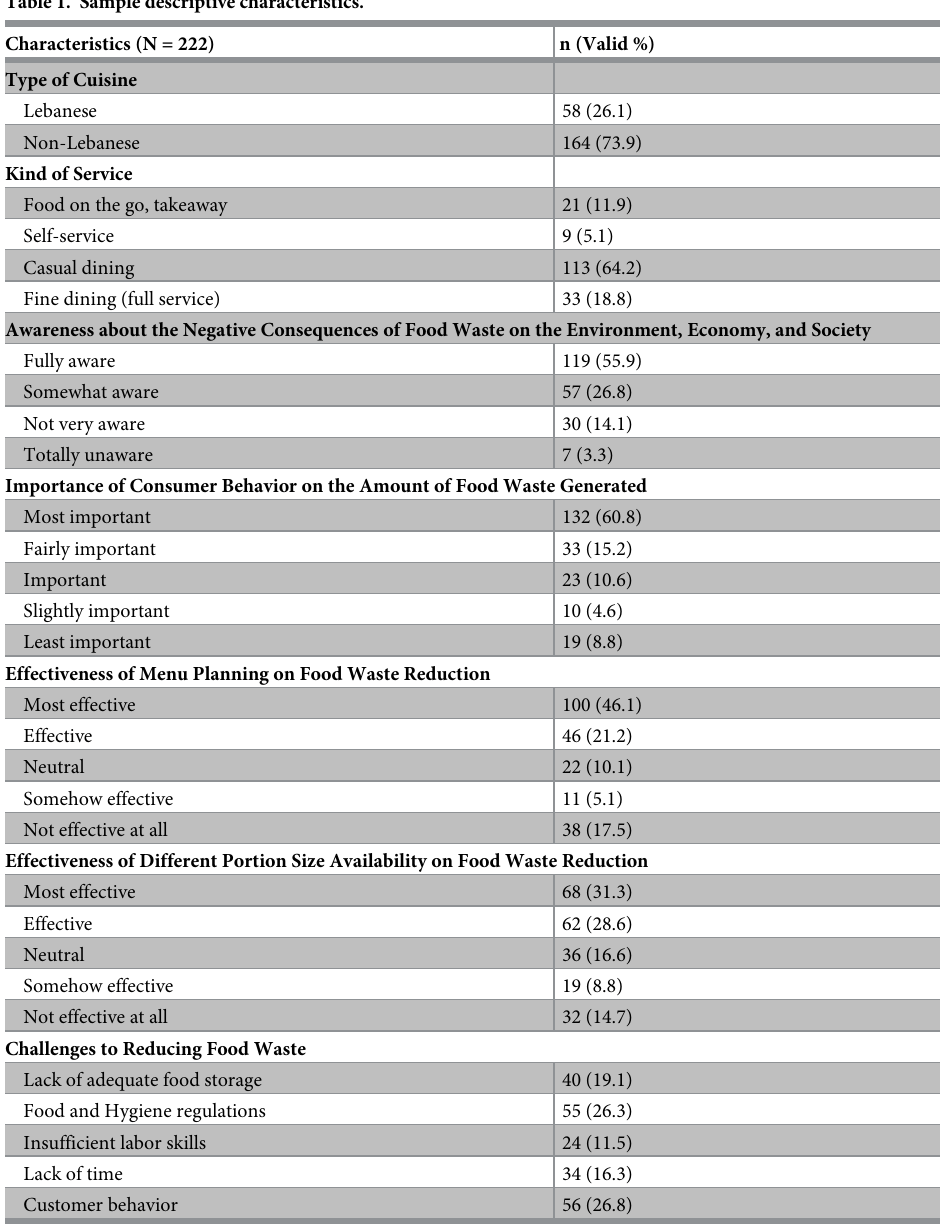
Table 1. Sample descriptive